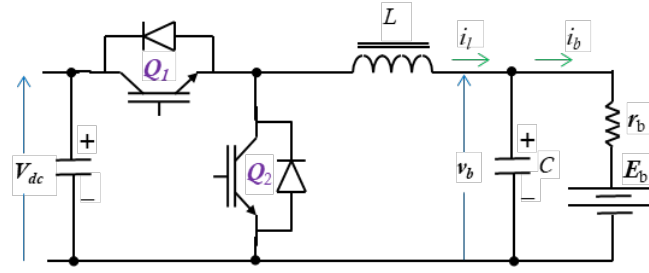
Figure 3. The circuit diagram of the bidirectional converter.